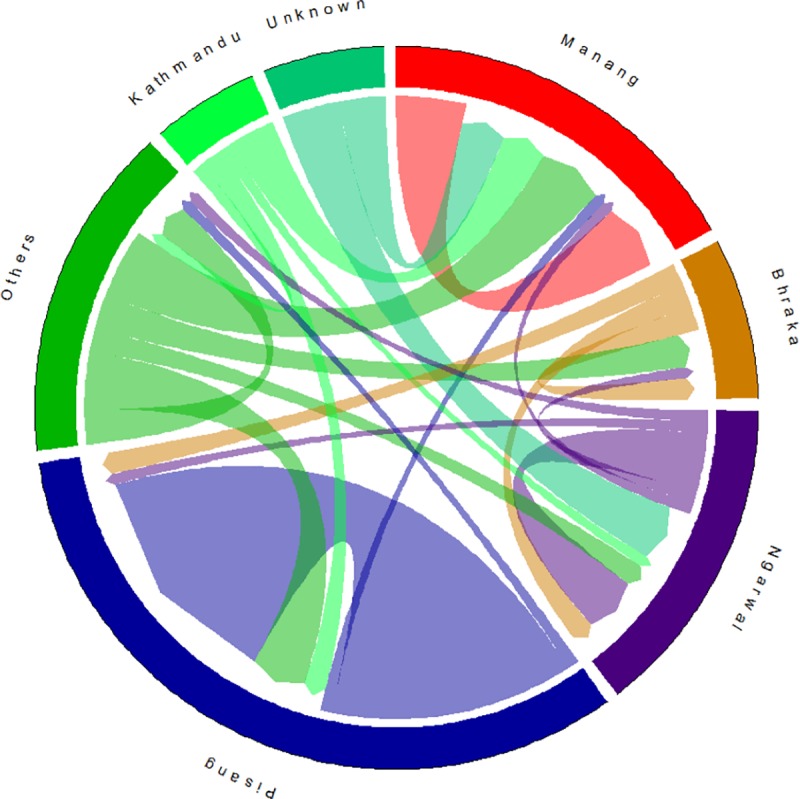
The circular plot visualizes the dispersal flows of dogs with owners residing in upper study region.The source and destinations of dogs are each assigned a colour and are represented by the circle’s segments. The direction of the flow is encoded by the origin colour and the direction of the arrows. The volume of movement is indicated by the width of the flow. Because the flow width is nonlinearly adapted to the curvature, it corresponds to the flow size only at the beginning and end points. ‘Others’ represents locations excluded from the analyses: Chame, Tankchok, Timang, Tache, Sapche, Nar, Ghorka, and Humdre. Sectors are arranged in proximity to each other, i.e. Manang is the neighbouring village west of Bhraka, and Ngawal is the neighbouring village east of Pisang.